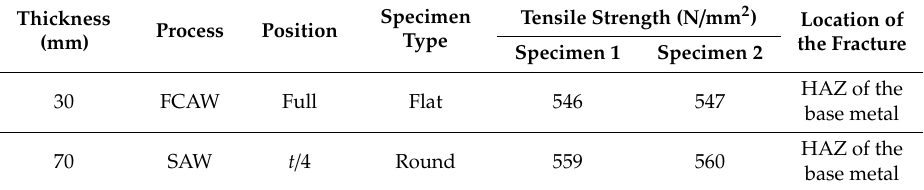
Table 6. Tensile test results of the welded joints. HAZ—heat a ff ected zone.